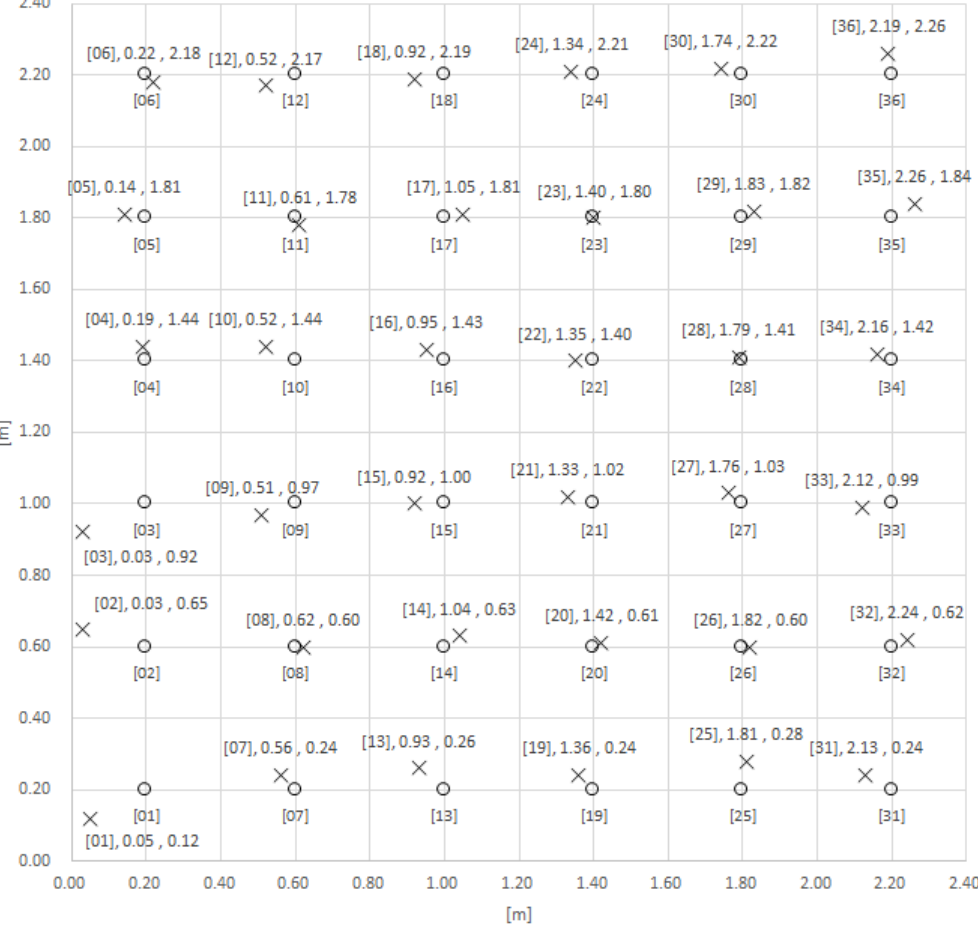
Figure 9. Evaluation result of measurement accuracy using Dacawave’s MDEK1001 Development Kit. The circle marks and the cross marks represent the installation position and the measurement position,